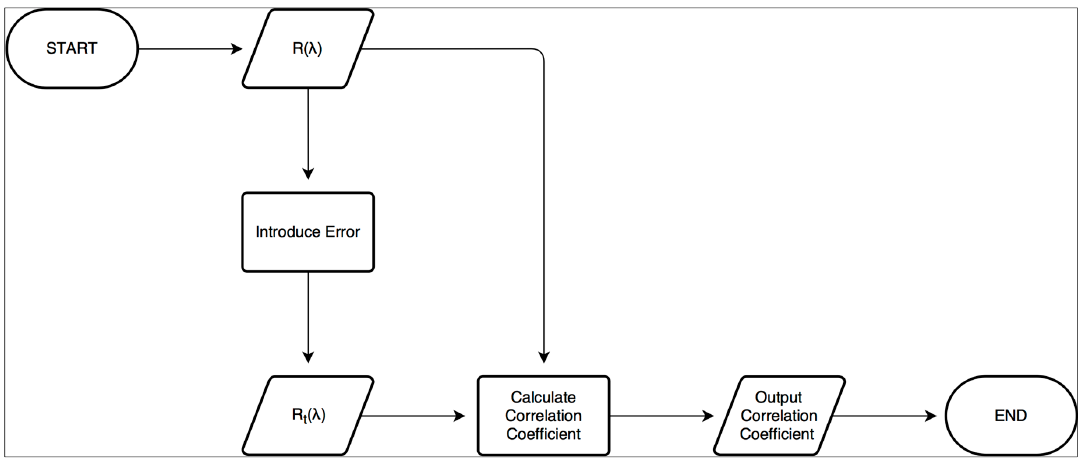
Figure 3. Schematic view of the basic algorithm for the characterization of the CC.